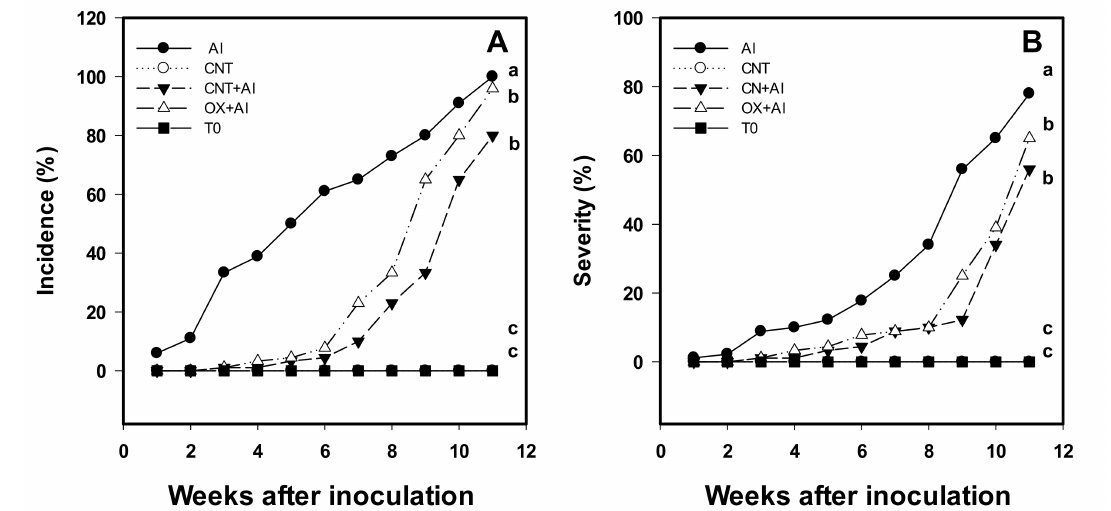
Figure 2. Incidence ( A ) and severity ( B ) of A. solani in the tomato crop plants. Al: Positive control inoculated with A. solani ; Nanomaterials 2021 , 11 , x FOR PEER REVIEW CNT: Carbon nanotubes; OX: Commercial control; T0: Control. Different letters indicate significant differences between treatments according to the least significant difference of Fisher test ( α = 0.05). N = 5 ± standard error.